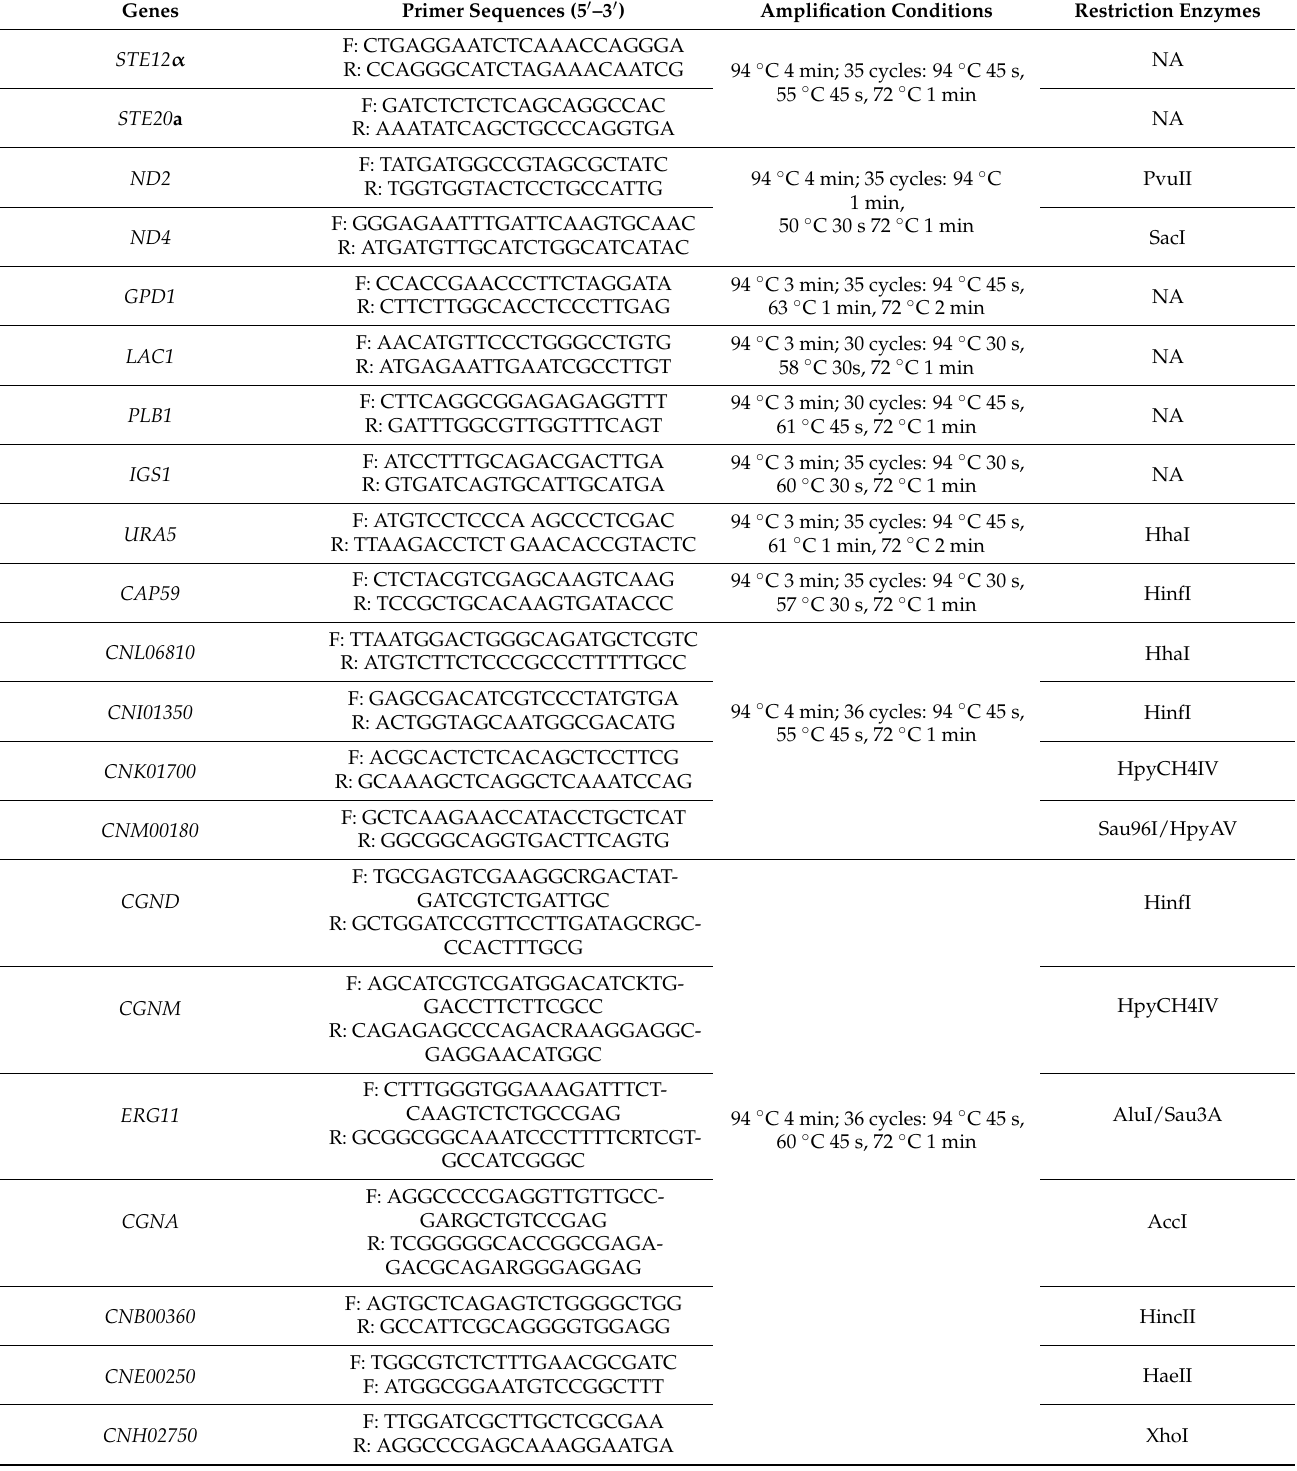
Table 2. Details of primers, polymerase chain reaction (PCR) protocols, and restriction enzymes that were used in this study. Genes Primer Sequences (5 (cid:48) –3 (cid:48) ) Amplification